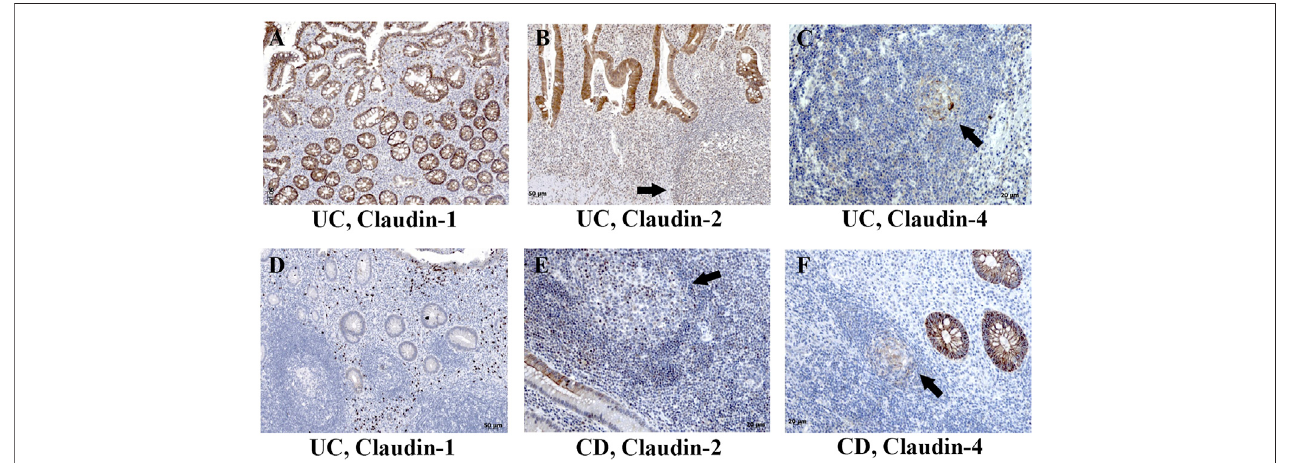
FIGURE 7 | Claudin-1, claudin-2, and claudin-4 expression by mononuclears and within tertian lymph nodes in colon of IBD patients. (A) Claudin - 1 (IHC), UC; (B) claudin-2 (IHC), UC; (C) claudin-4 (IHC), UC; (D) claudin-1 (IHC), UC; (E) claudin-2 (IHC), CD; (F) claudin-4 (IHC), CD. Highlighted features: claudin positive cells within tertian lymph nodes (arrows). CD, Crohn disease; UC, ulcerative colitis.